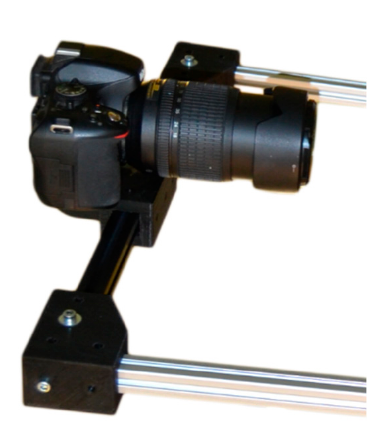
Figure 7. Nikon Camera. (Source: Self-made).